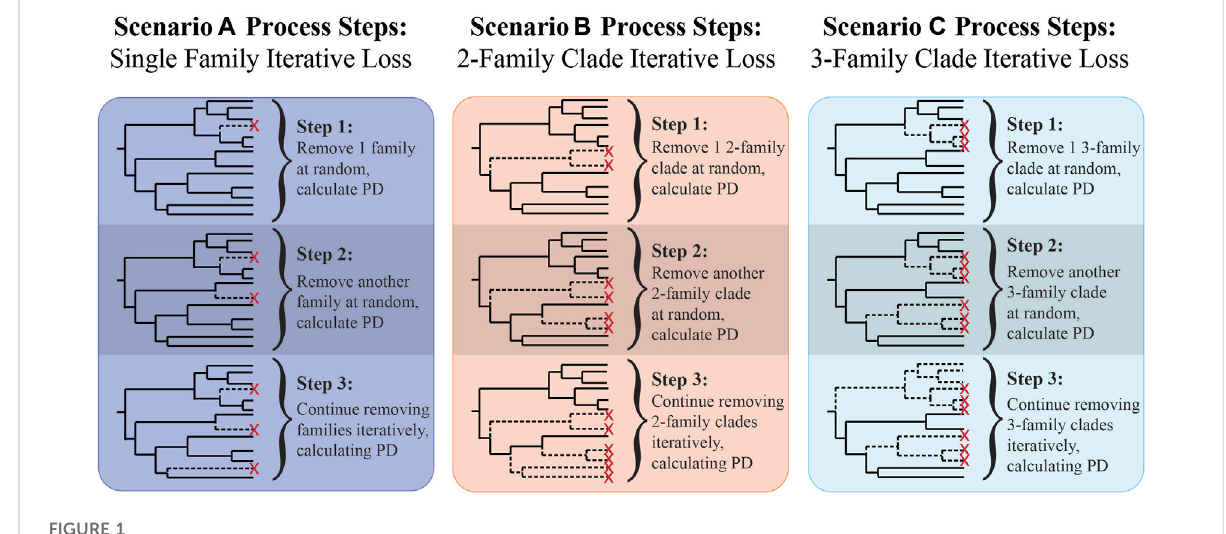
FIGURE 1 Illustration of scenario A, B, and C process steps used in the sensitivity analysis to test the effects of family clade size